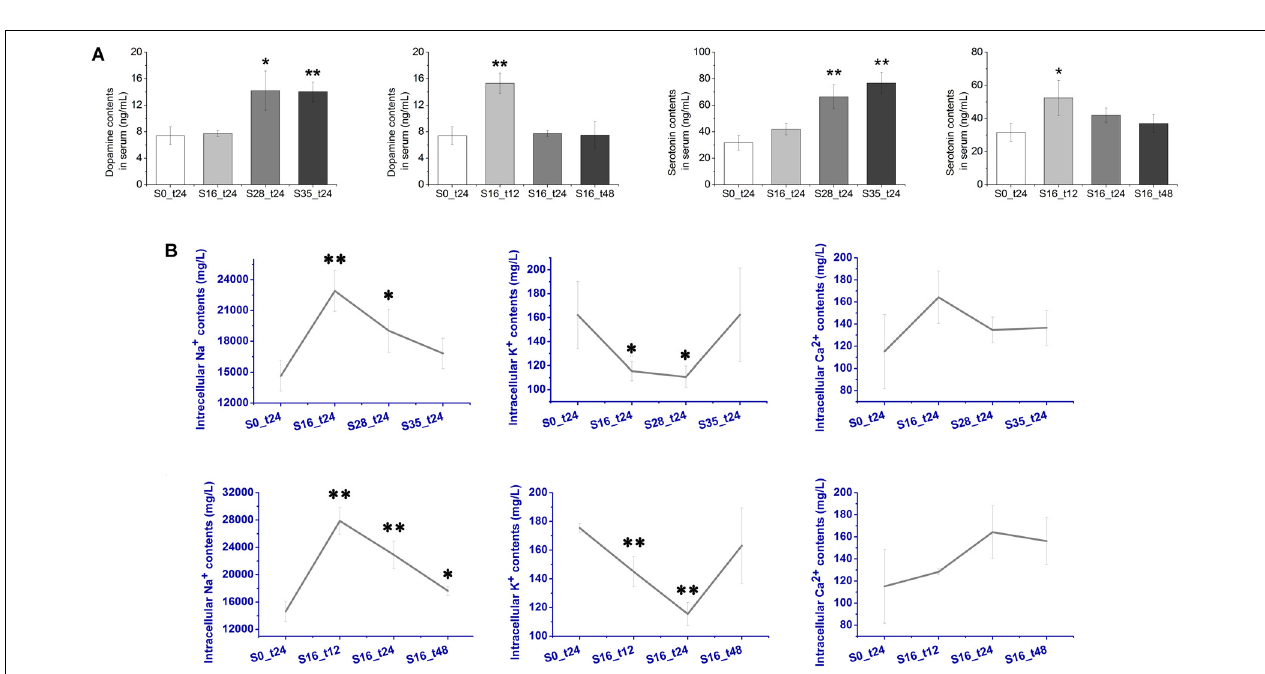
FIGURE 2 | Contents of dopamine (DA), serotonin (5-HT), and intracellular ions after salinity stress. (A) Contents of monoamine neurotransmitters DA and 5-HT in crab serum after salinity stress. (B) Contents of intracellular Na + , K + , and Ca 2 + in crab hemocytes after salinity stress.